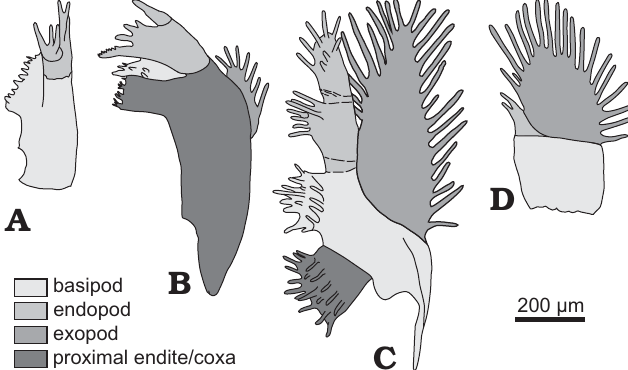
Fig. 2. Terminology of limb morphology of Cyclotron angelini (Linnarson, 1875). A . Antenna. B . Mandibula. C . 1st post-mandibular limb. D . Terminal